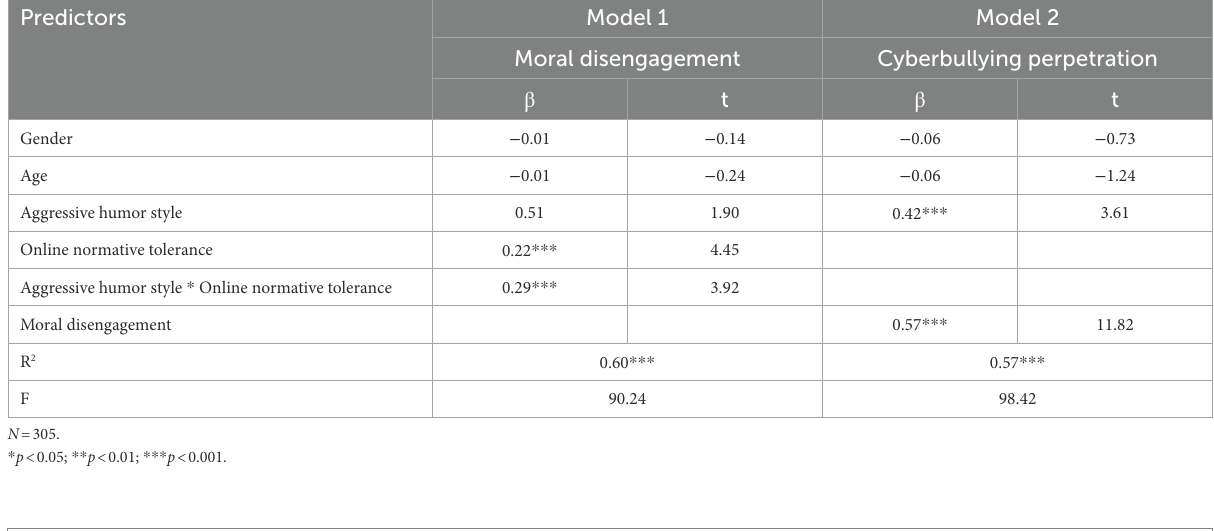
TABLE 3 Regression results.